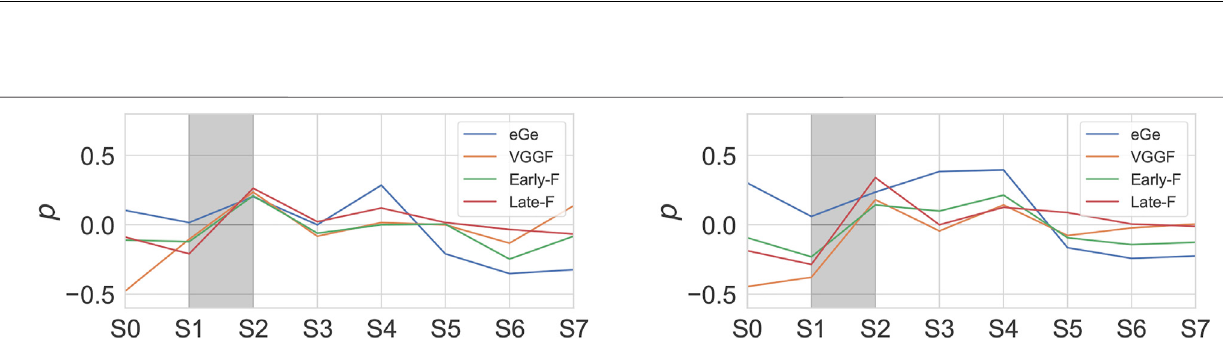
FIGURE7| Normalisedframe-wisecortisolpredictions(continuous)vsgroundtruth(dashed)sampledattimesS2-S5using EGEMAPS featuresforsubjectsF-1from FAU-TSST and subject R-1 from REG-TSST . The shaded (green) area represents segments detected as having speech by the VAD. Predictions are smoothed with a moving average fi lter with a window size of 30 for visibility. (A) F-1 S2, (B) F-1 S3, (C) F-1 S4, (D) F-1 S5, (E) R-1 S2, (F) R-1 S3, (G) R-1 S4, (H) R-1 S5.